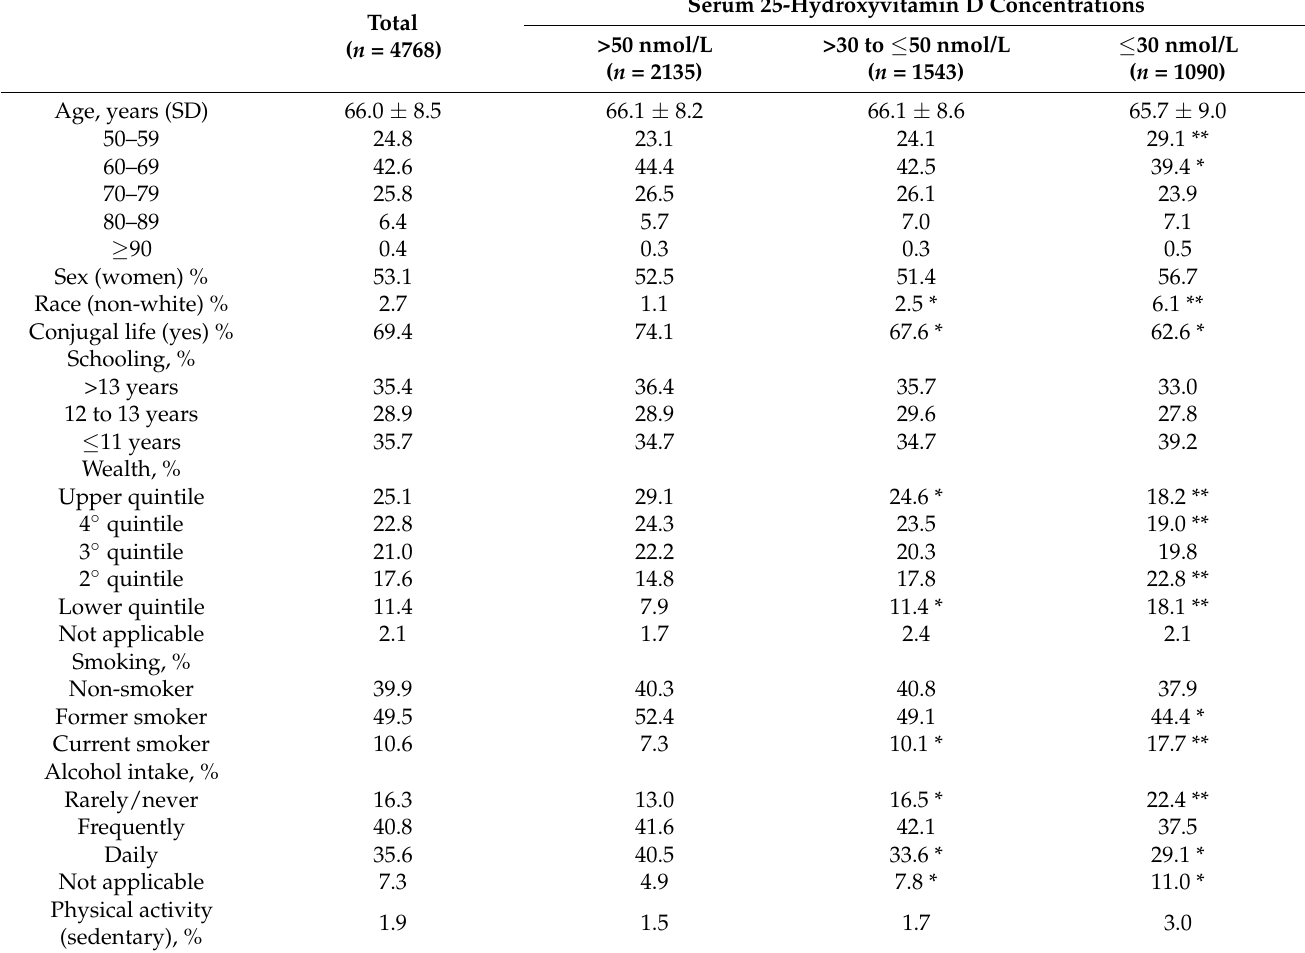
Table 1. Socioeconomic characteristics and health-related behaviors of 4768 participants